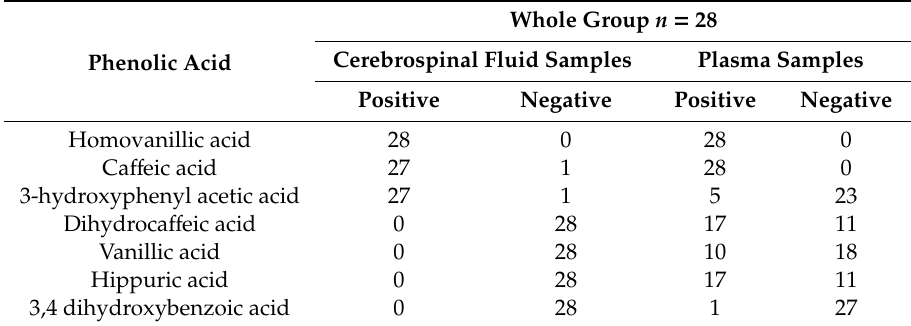
Table 2. Number of cerebrospinal fluid and plasma samples with detectable levels of studied polyphenols.